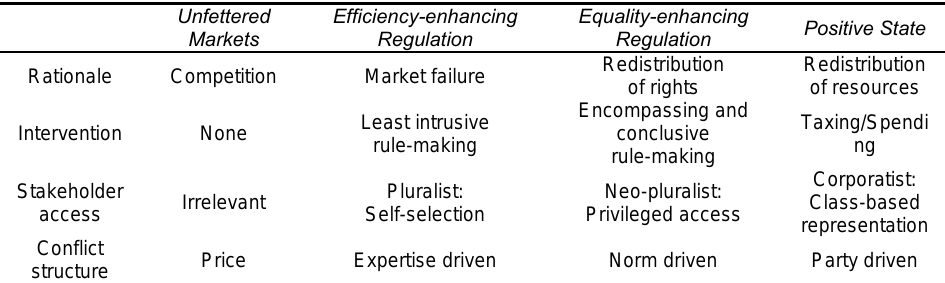
Table 1: Ideal-type models of regulation in between unfettered markets and the positive welfare state Unfettered